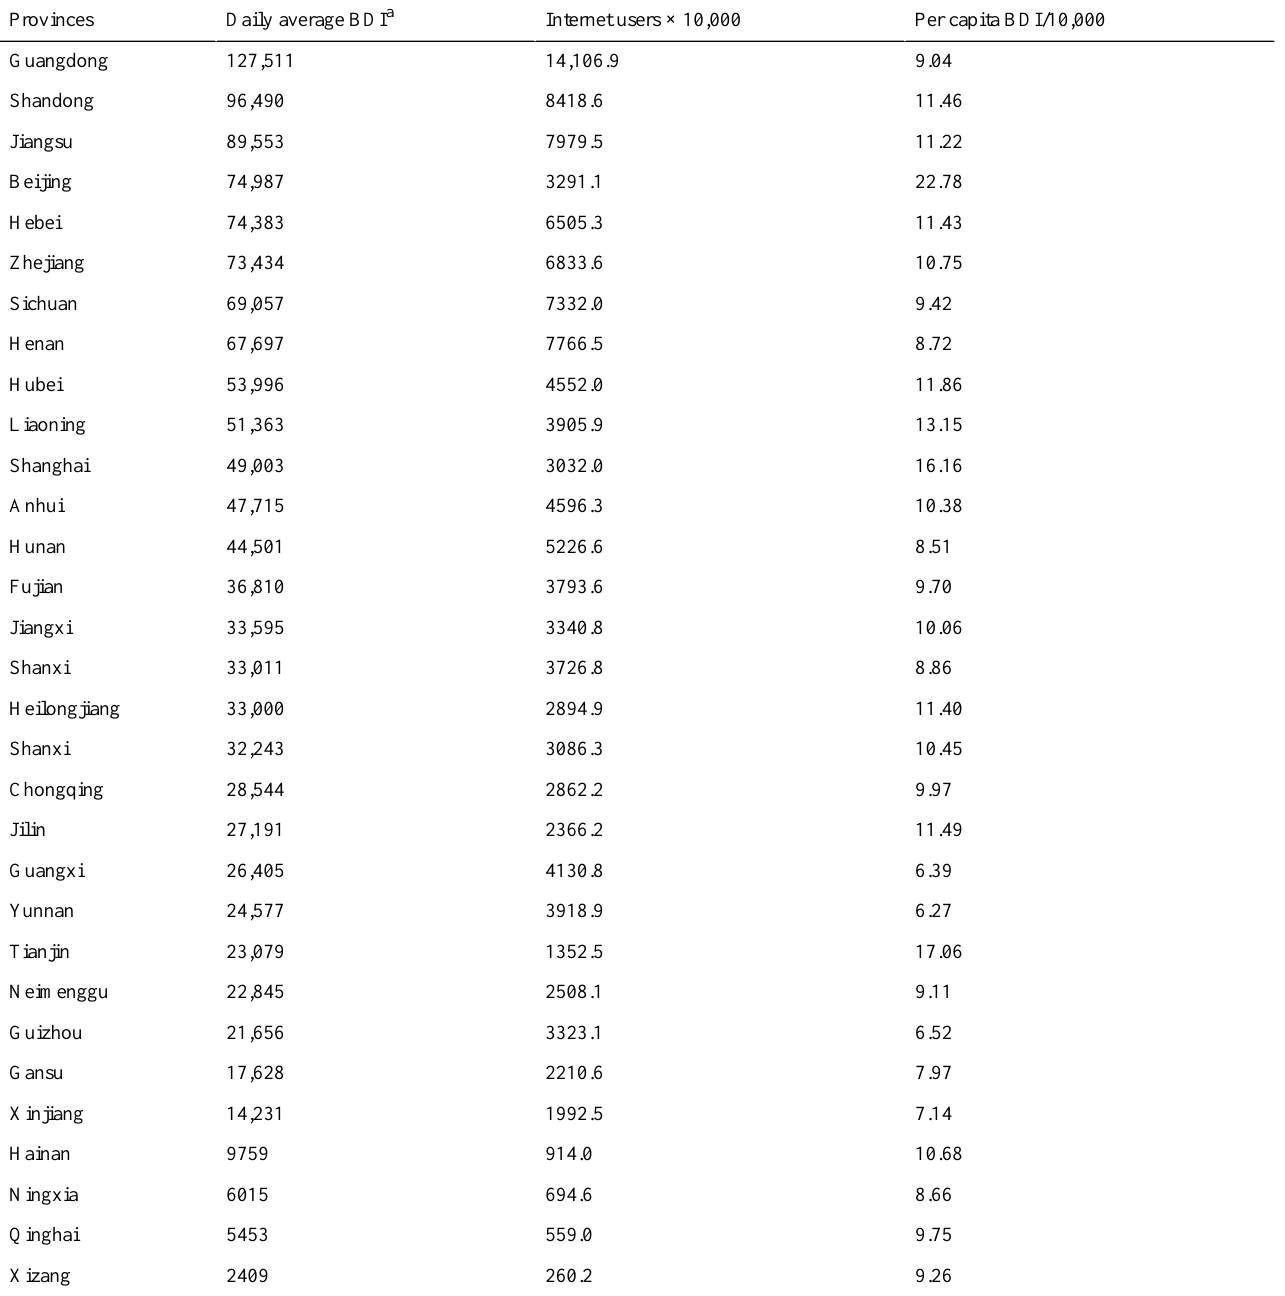
Table 1. The daily average BDI and per capita BDI in each province from December 8, 2019, to April 20,